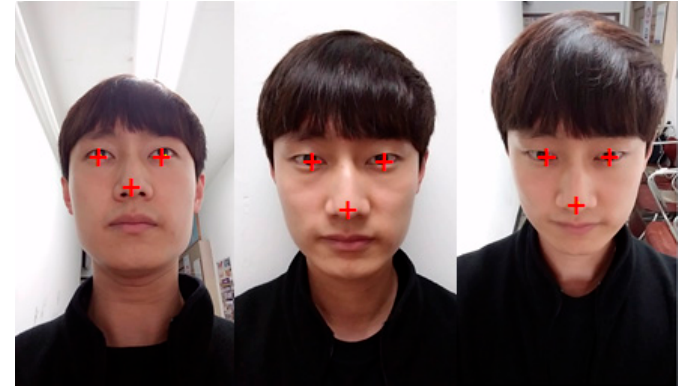
Figure 4. Results for the multitask cascaded convolutional network (MTCNN) using real face data.